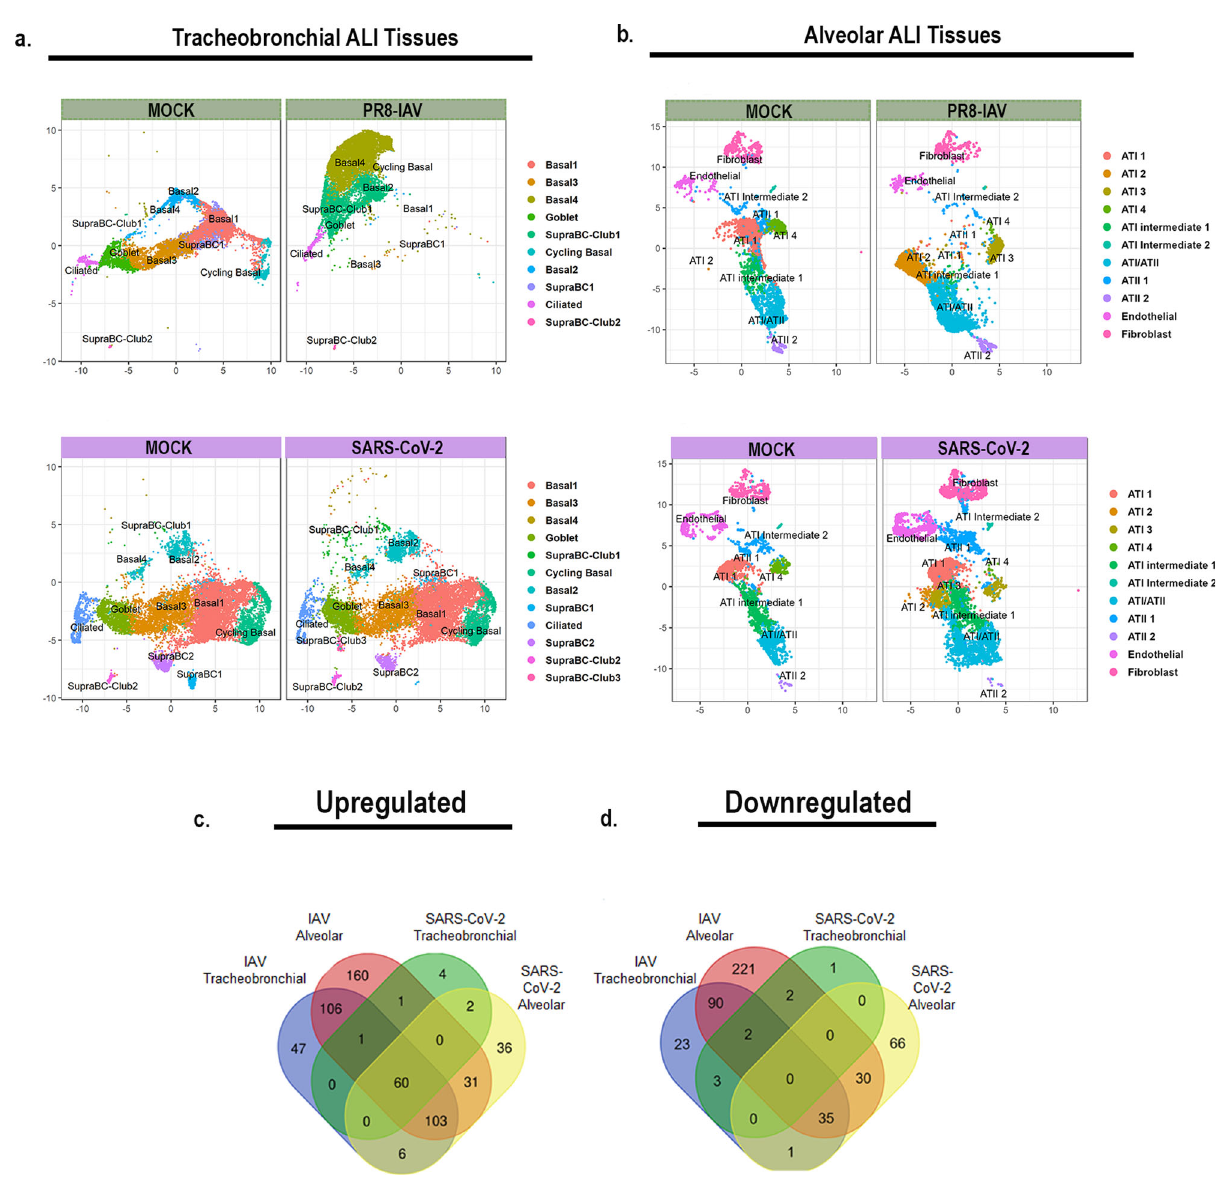
Fig. 5 ScRNAseq UMAP plots of IAV or SARS-CoV-2 infected lung ALI tissues. Tracheobronchial and alveolar ALI tissues were infected with PR8 IAV (1e5 TCID50 units/tissue, n = 2) for 48 h or SARS-CoV-2 (2e5 PFU/tissue, n = 2) for 72 h prior to dissociation for scRNAseq. Shown here are UMAP plots of: ( a ) Tracheobronchial tissues infected with mock media or PR8 IAV for 48 h (top, green), or with mock media or SARS-CoV-2 for 72 h (bottom, purple). b Alveolar tissues infected with mock media or PR8 IAV for 48 h (top, green), or with mock media or SARS-CoV-2 for 72 h (bottom, purple). Venn diagrams showing viral and tissue unique or shared genes with Log2FC values ( c ) >0.264 or ( d ) <-0.264 over mock in IAV or SARS-CoV-2 infected airway and alveolar